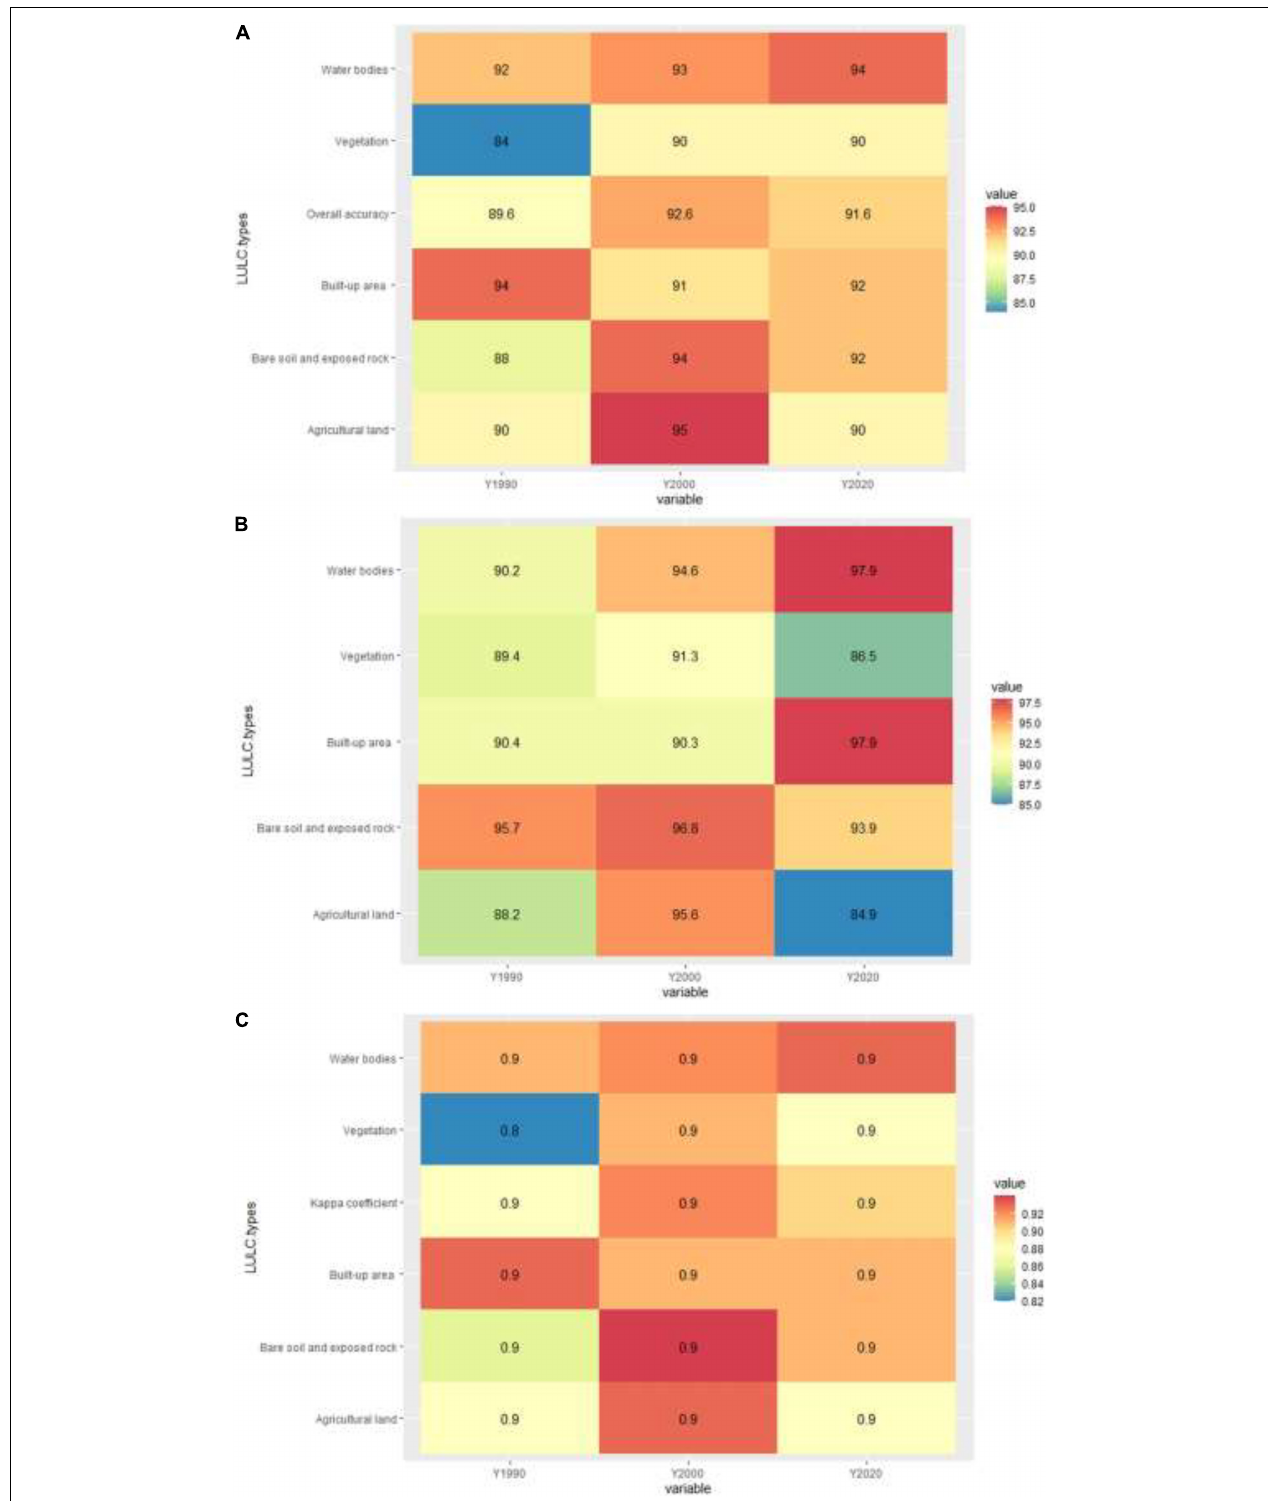
FIGURE 3 | The accuracy assessment of LULC maps of 1990, 2000, and 2018 using (A) user accuracy, (B) producer accuracy, and (C) conditional accuracy with kappa coefficient.